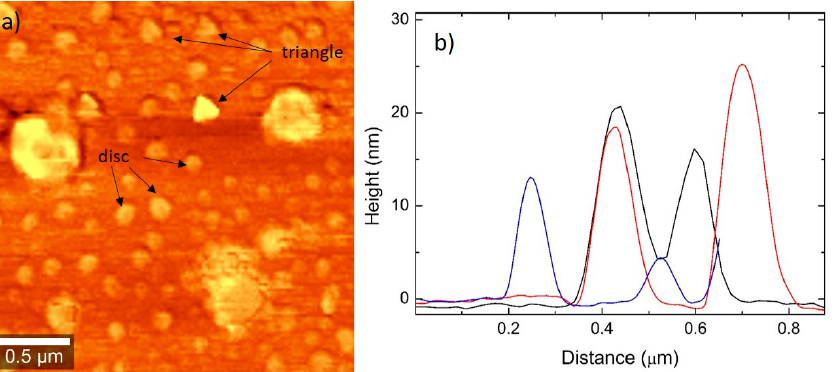
Figure 4. ( a ) AFM image showing Ag NPTs of mixed shapes (mainly triangles and discs); ( b ) AFM profiles showing most profiles in the range of 10–20 nm in thickness.